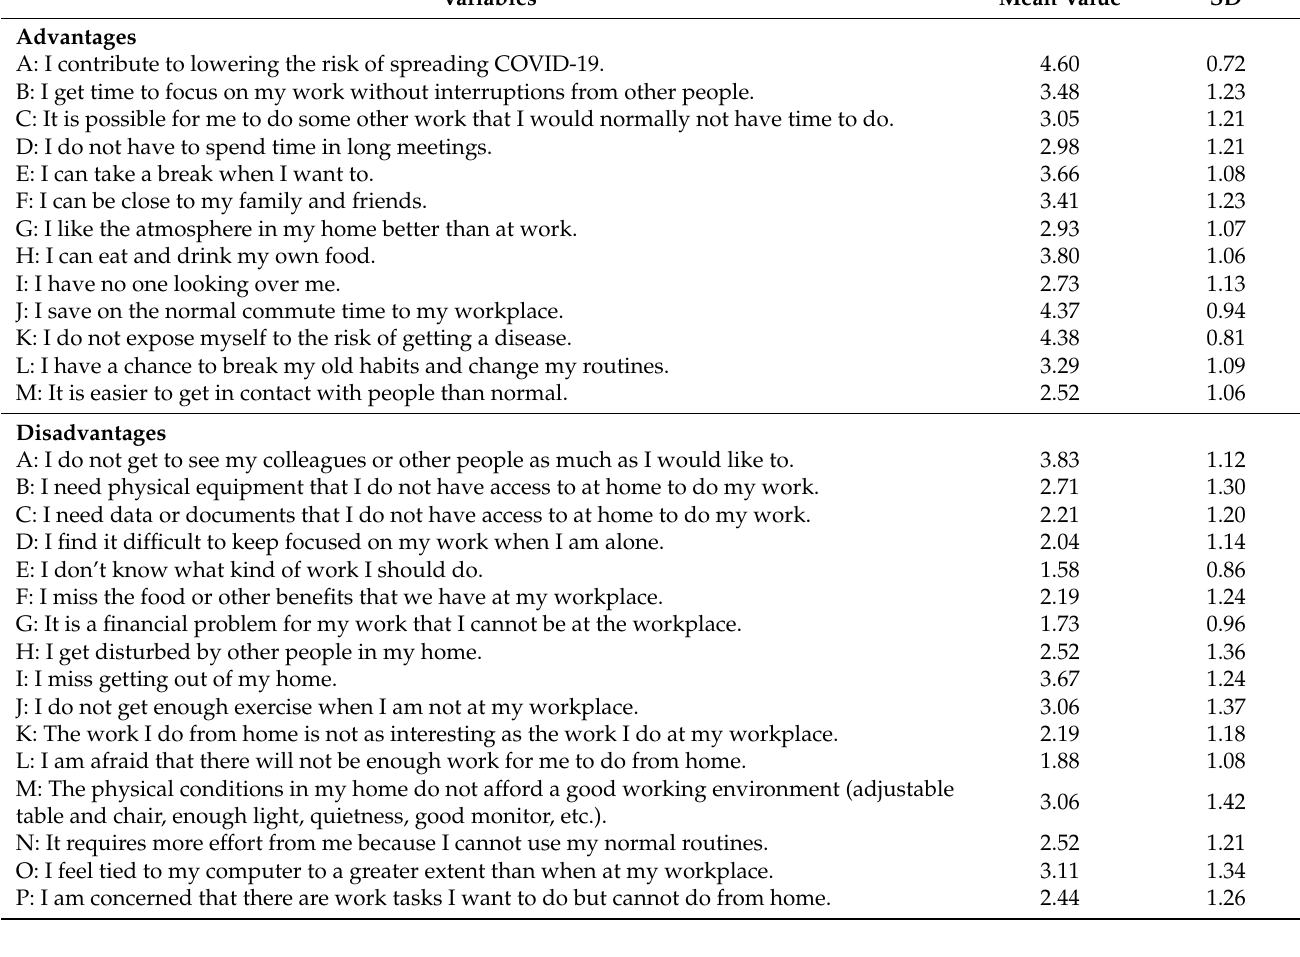
Table 2. Overview of advantages and disadvantages of WFH. Variables Mean Value